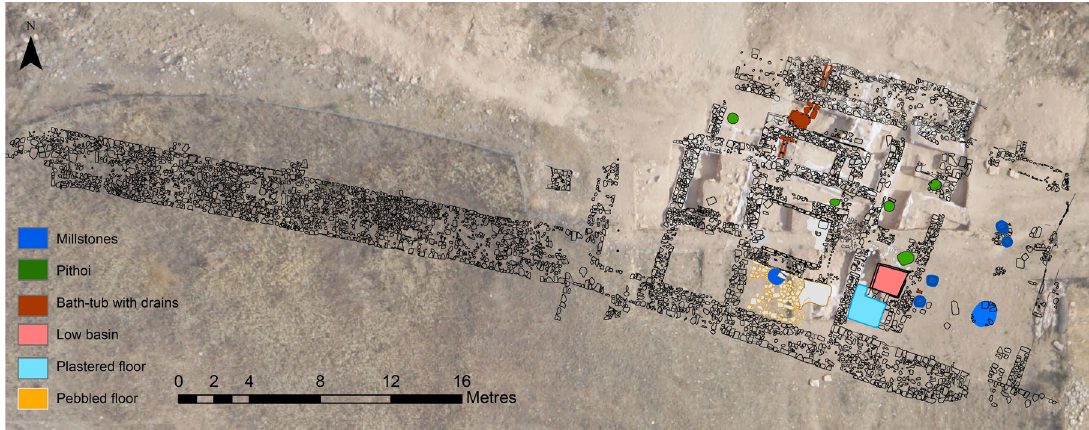
Figure 19. Hadjiabdoulla West complex; ground plan of excavated units to north of citadel parapet wall. A. Agapiou & R. Soler 2019 (PULP@).